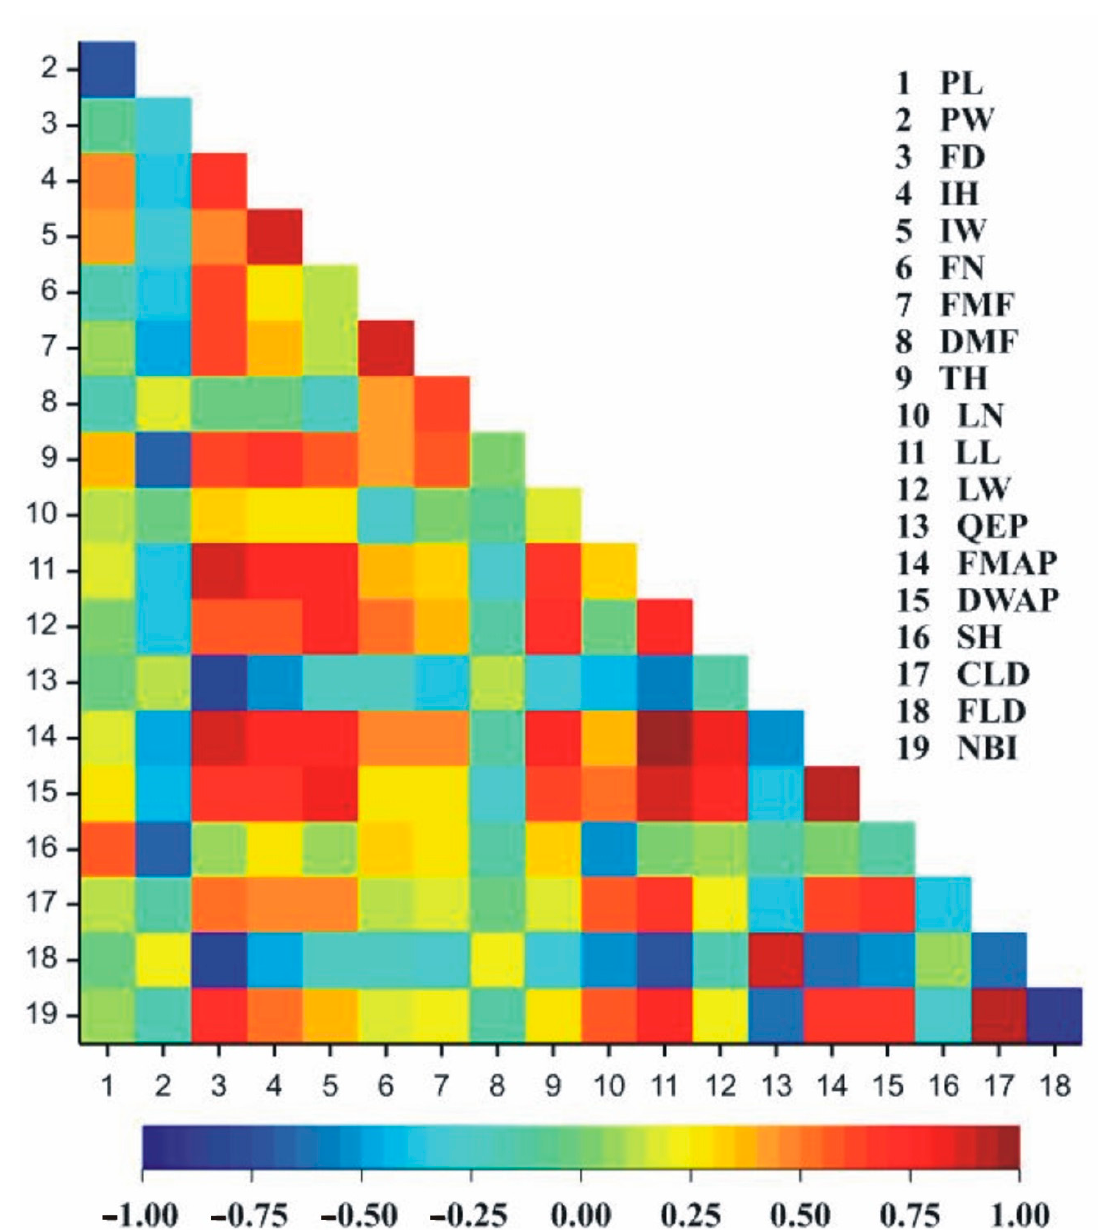
Figure 2. Heatmaps for linear Pearson’s correlation coefficients between the observed traits: CPG and PPG in 4, 8 and 12 weeks. Table 6. Correlation coefficients between observed traits.